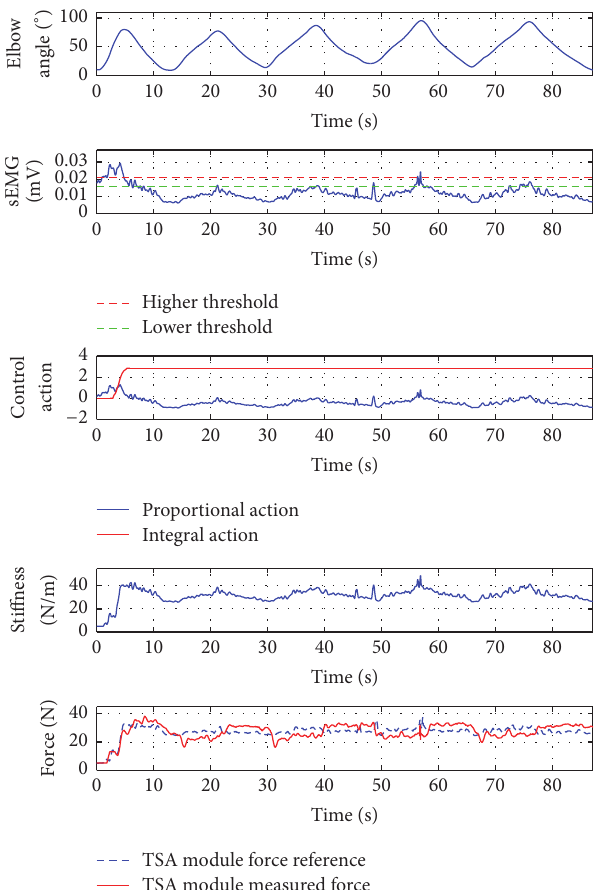
Figure 13: Plots for the lifting task with the assistive device